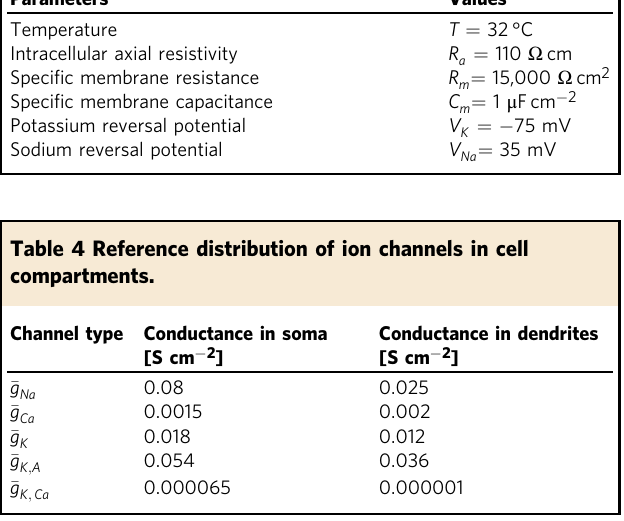
combinations. Model parameters (Table 3) and channel conductances (Table 4) were taken from Fohlmeister and Miller (ref. 67 ). To identify parameters that explain the